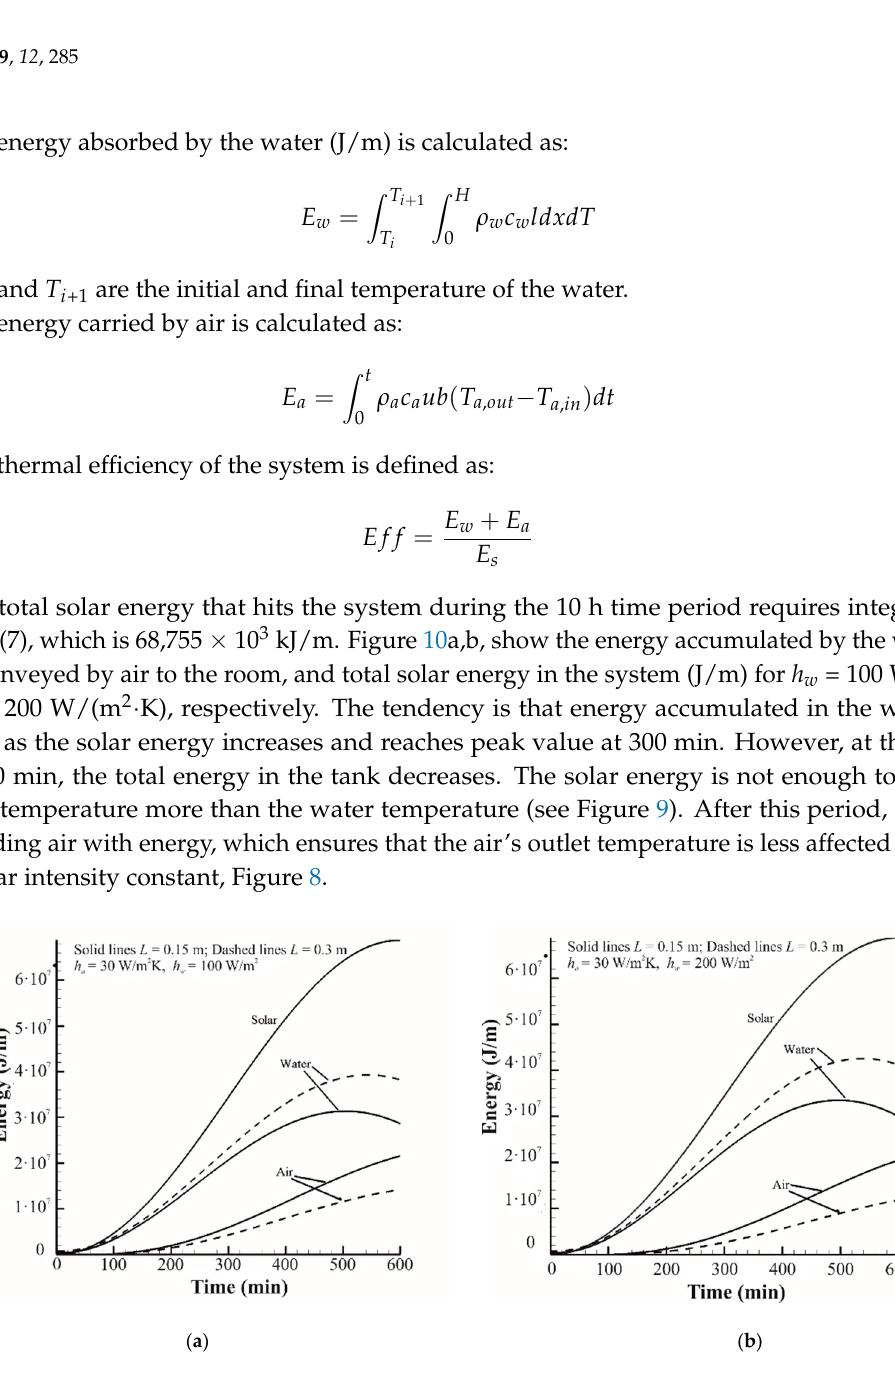
Figure 10. Energy versus time in the system, ( a ) for h w = 100 (W/m 2 ·K) and ( b ) for h w = 200 W/(m 2 ·K).